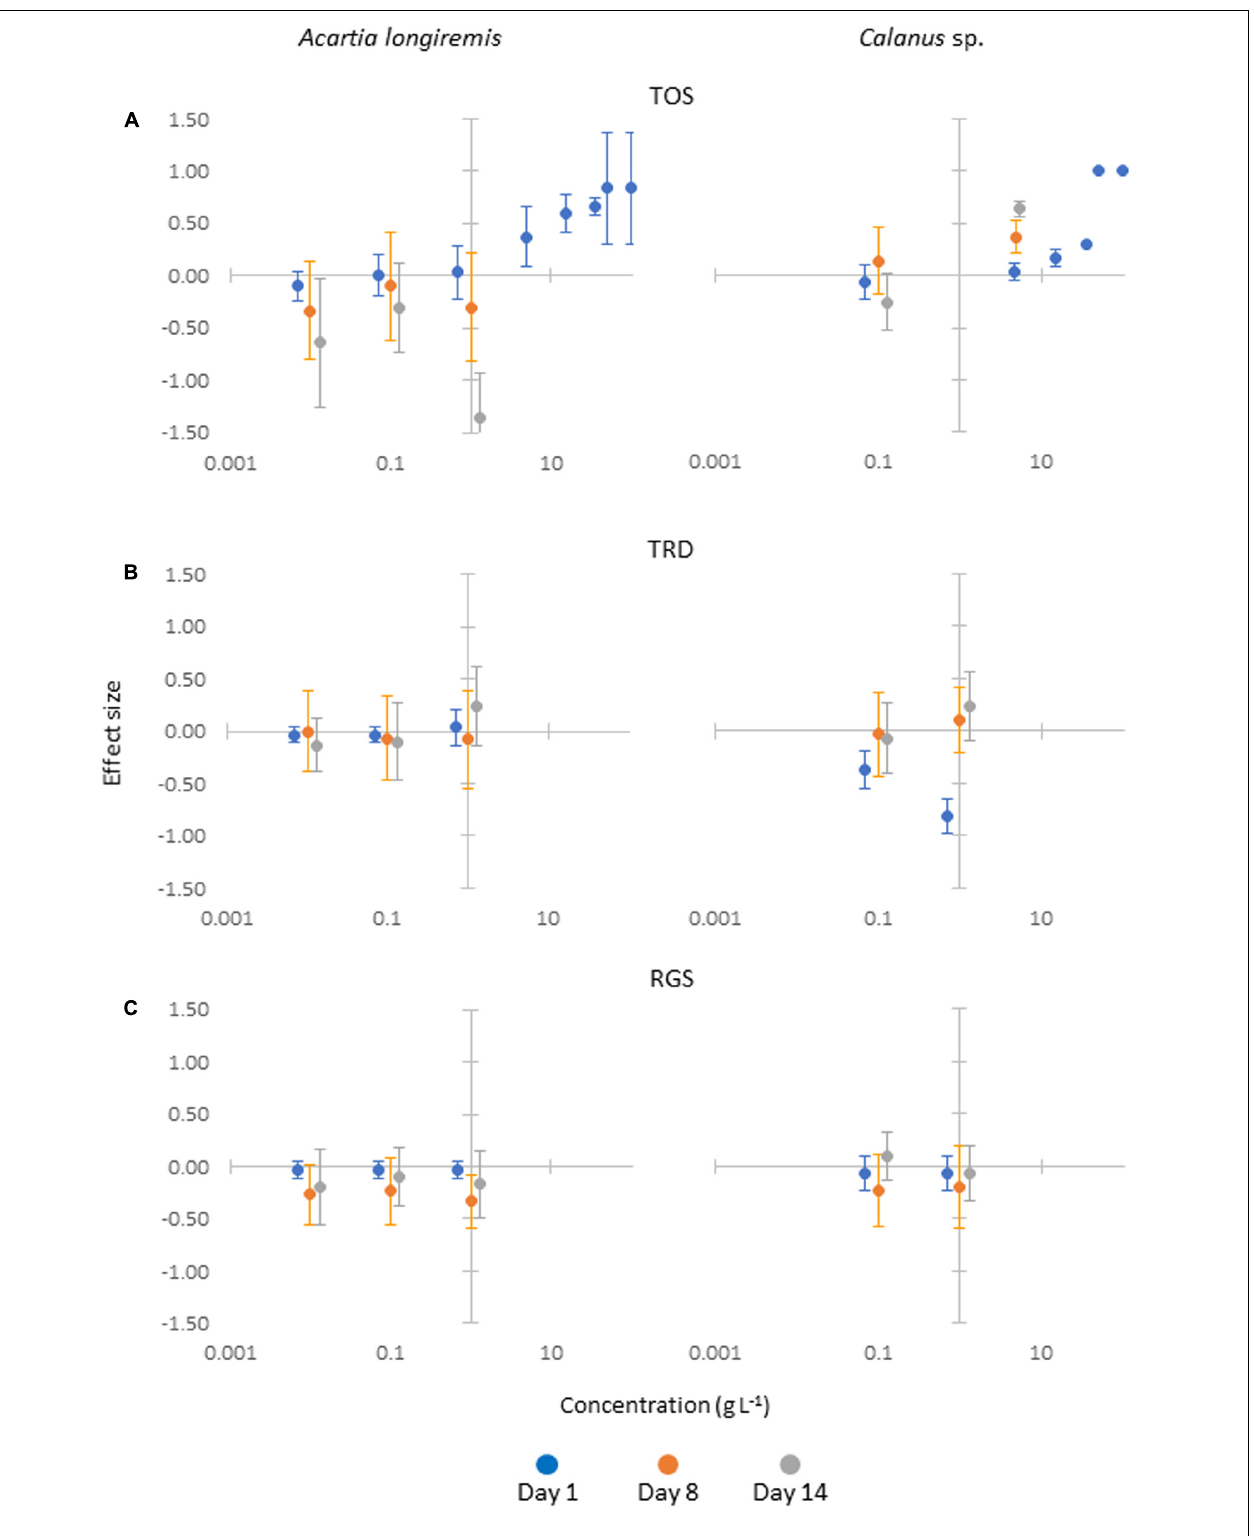
FIGURE 5 | Effect sizes of different CRG concentrations for Acartia longiremis (left) and Calanus sp. (right) for three CRG types: (A) TOS, (B) TRD, and (C) RGS. Positive values with error bars not crossing the zero line indicate significantly higher mortality in leachate treatments than in controls.